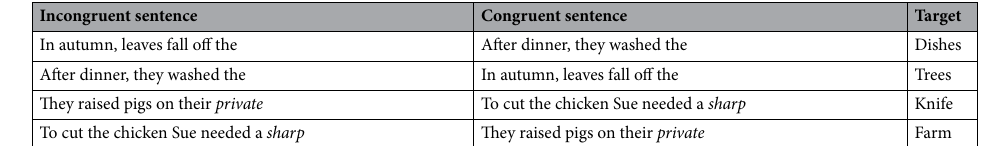
Table 1. Example of congruent and incongruent sentences. The conditions are matched by pairing the targets between the two conditions. In some cases (last two rows), we added an adjective (italics) ending with a plosive sound before the target word to facilitate audio splicing (see Supplementary Table S1 for a complete list of the